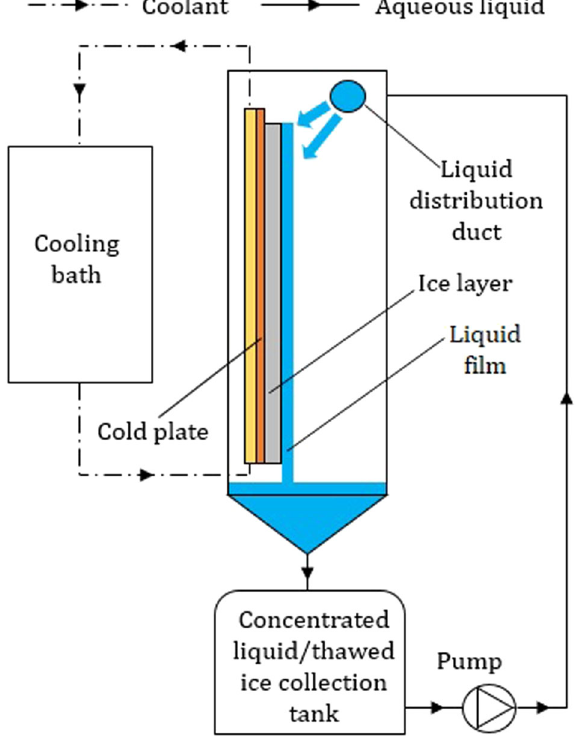
Fig. 5 Schematic of the falling- fi lm freeze-concentration process. The aqueous liquid to be concentrated fl ows down over the cooling surface where the crystallization occurs.